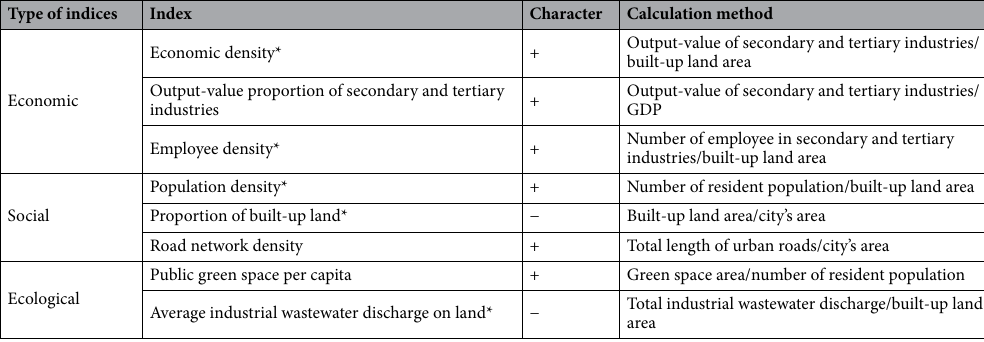
Table 1. Evaluation index system of ILU degree. The index marked with * were calculated by extracting built-up land information in the GEE platform, while all other indices were taken from the statistical data. The “+” in the Character column means a positive index, and “−” means a negative index.